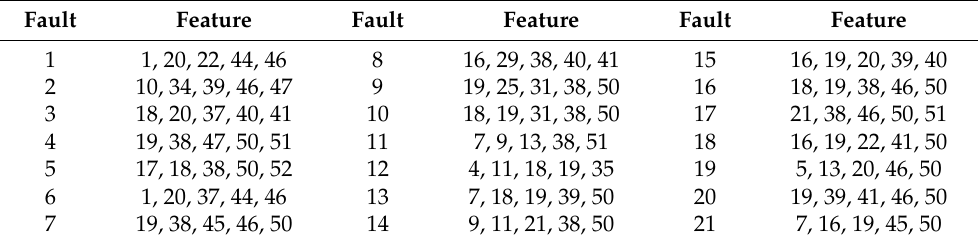
Table 2. Selected features for each